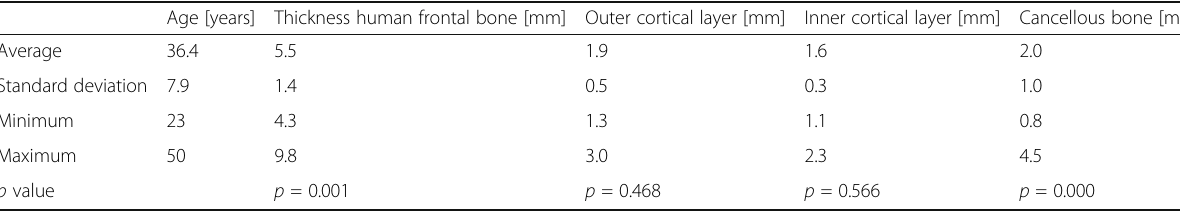
Table 2 Frontal bone